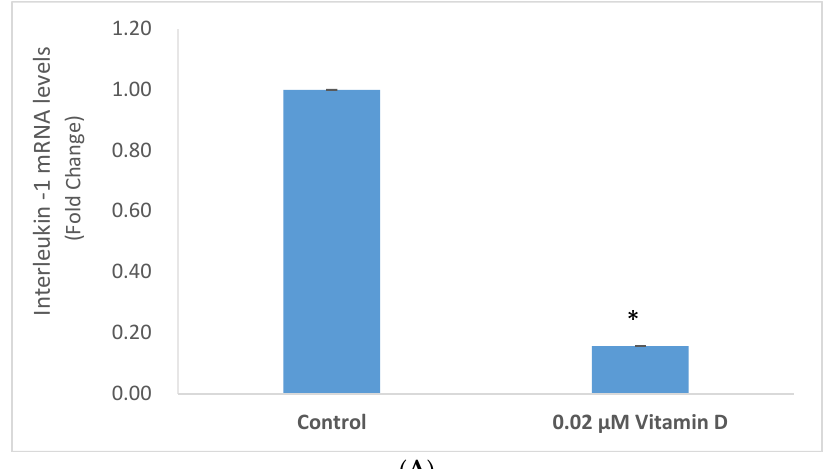
Figure 3. Effect of 1 α ,25-dihydroxyvitamin D3 (vitamin D) on interleukin-1 (IL-1) ( A ), and tumor necrosis factor alpha (TNF-α) ( B ) protein levels in melanoma cells; error bars: standard deviation, n = 4; * = p < 0.05, relative to control.